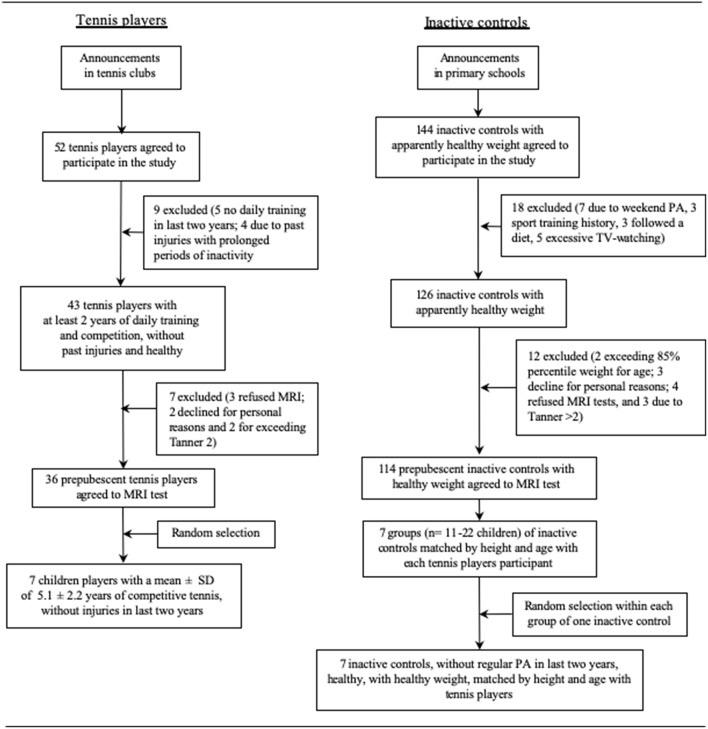
Flow chart for the selection of children tennis players and inactive controls.